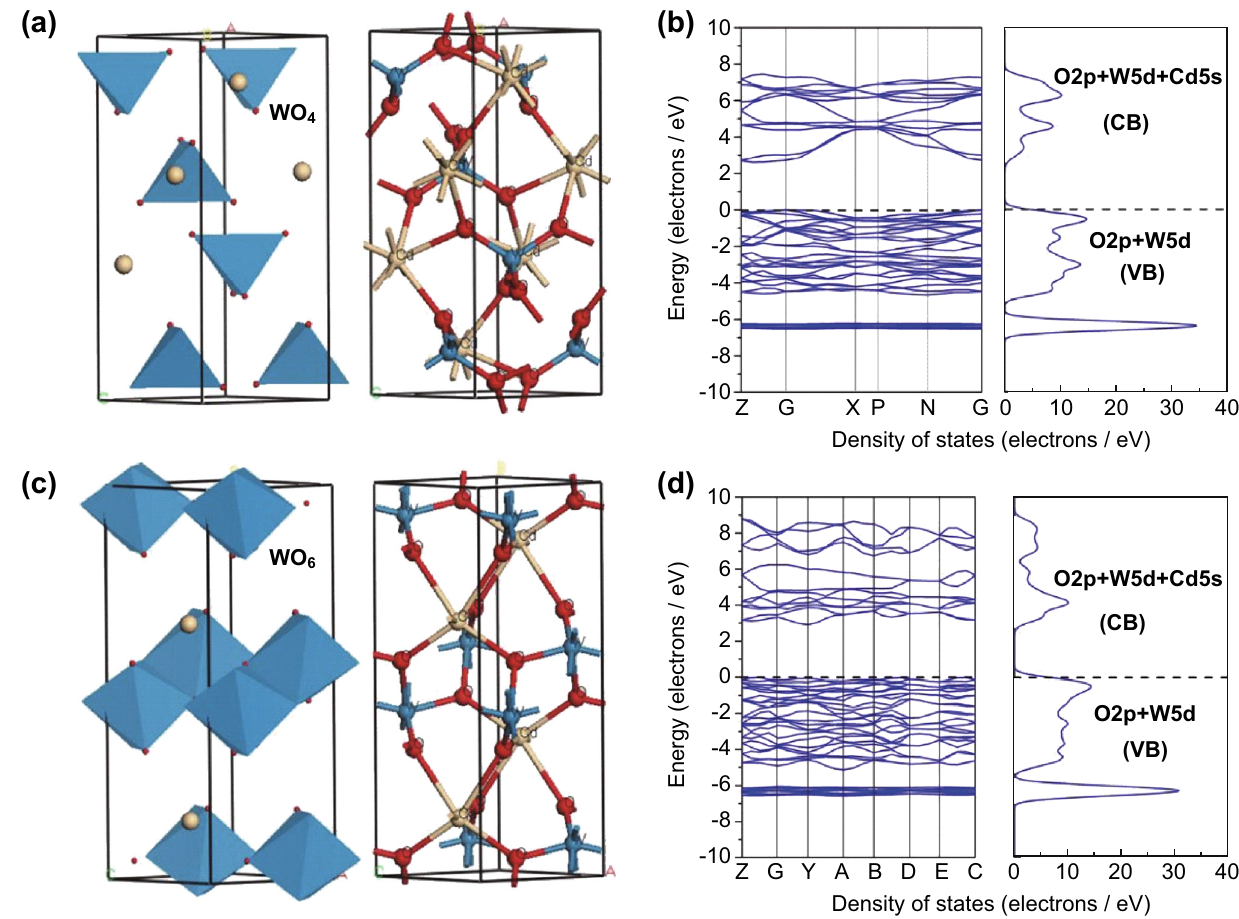
Fig. 5 Models of band structures and calculated density of states for tetragonal ( a, b ) and monoclinic ( c, d ) CdWO 4 . Reproduced with permission from Ref. [83]. Copyright 2011